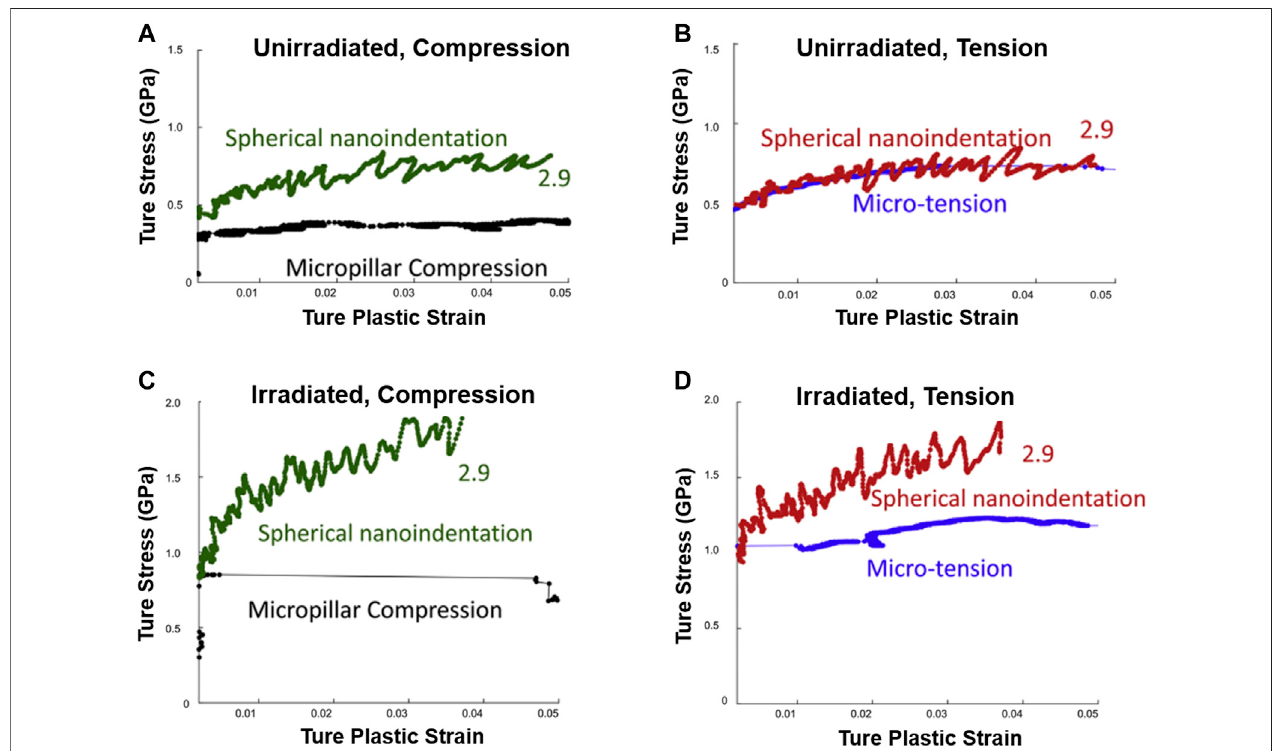
FIGURE 6 | The comparison of the uniaxial engineering stress-strain curves and indentation stress-strain of unirradiated (A,B) and irradiated 304 stainless steels (C,D) , obtained from micro-compression, micro-tension, and spherical nanoindentation tests. Adapted from Weaver et al. (2017). Reproduced with the permission of the copyright holder